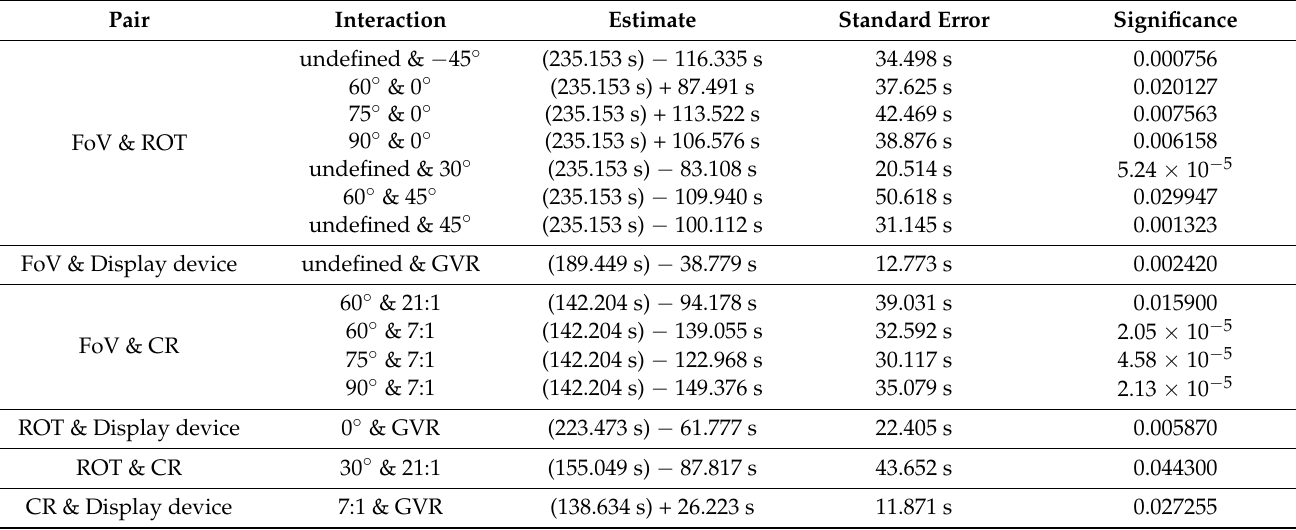
Table 2. Significant interactions among variable pairs.